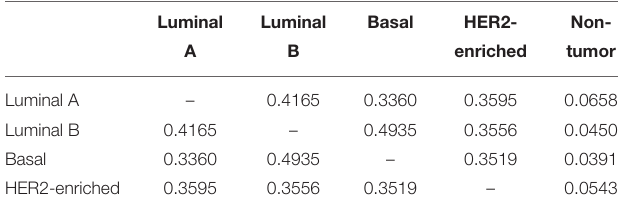
TABLE 2 | Jaccard indexes for each pair of transcriptional network node sets. Luminal Basal HER2- Non-